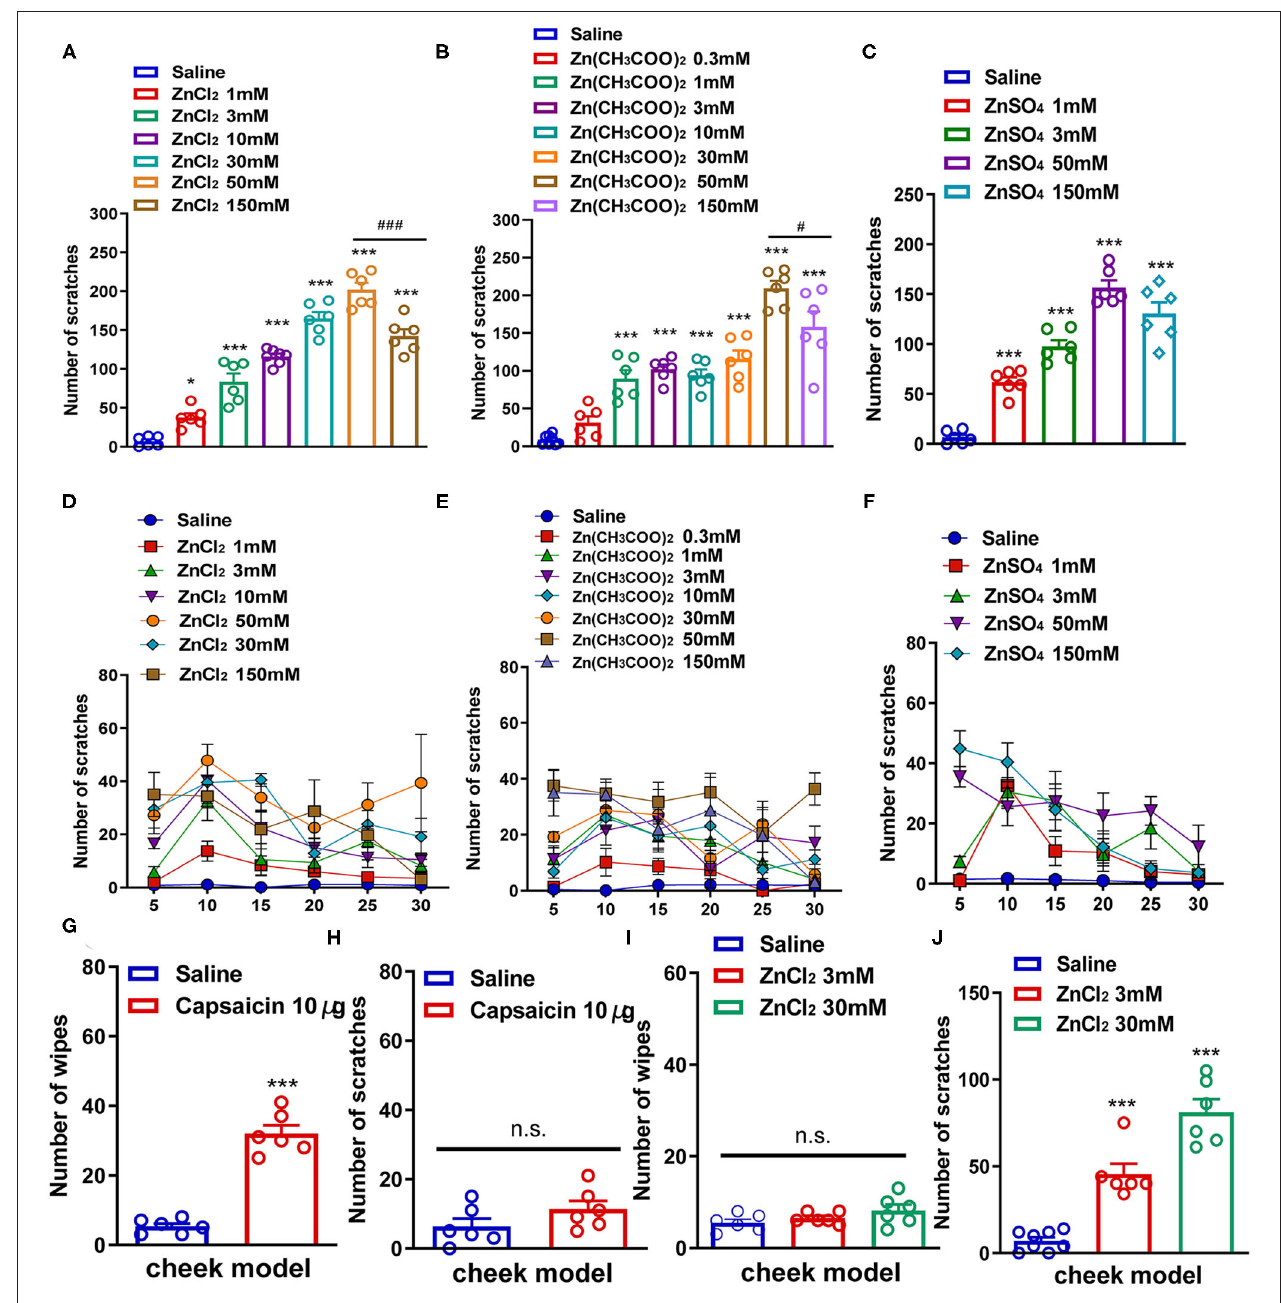
FIGURE 1 | Zn 2 + evoked a scratching behavior in the neck and cheek models of mice. (A,D) The total number (A) and time course (D) of the scratching behavior induced by intradermal (i.d.) injection of ZnCl 2 (1–150mM) in the nape of the neck in mice. (B,E) The total number (B) and time course (E) of scratching behavior induced by i.d. injection of Zn(CH 3 COO) 2 (0.3–150mM) in the nape of the neck in mice. (C,F) The total number (C) and time course (F) of the scratching behavior induced by i.d. injection of ZnSO 4 (1–150mM) in the nape of the neck in mice (* P < 0.05, *** P < 0.001 vs. Saline, ### P < 0.001 vs. 50mM ZnCl 2 , # P <0.05 vs. 50mM Zn(CH 3 COO) 2 , one-way AVOVA following post-hoc Bonferroni’s test; n = 6–8 per group). (G,H) The total number of wiping (G) and scratching behavior (H) induced by i.d. injection capsaicin (10 µ g) in the cheek in mice. (I,J) The total number of wiping (I) and scratching behavior (J) induced by i.d. injection ZnCl 2 (3 and 30mM) in the cheek in mice (*** P < 0.001 vs. Saline, unpaired Student’s t -test; n = 6–8 per group). All data are expressed by means ± SEM. n.s., not significant. P = 0.0067; Figure 2B ). In addition, histamine-induced itch of mice showed that chlorpheniramine attenuated histamine- was significantly increased by the coadministration of ZnCl 2 induced itch in mice ( t 10 = 3.444, P = 0.0063; Figure 2A ). (3 mM) and histamine (800 µ g) in the nape of the neck of Co-administration of ZnCl 2 (3 mM) and chlorpheniramine (300 µ g) also attenuated ZnCl 2 -induced itch in mice ( t 10 = 3.410, mice ( t 10 = 2.241, P = 0.0489; Figure 2C ), but